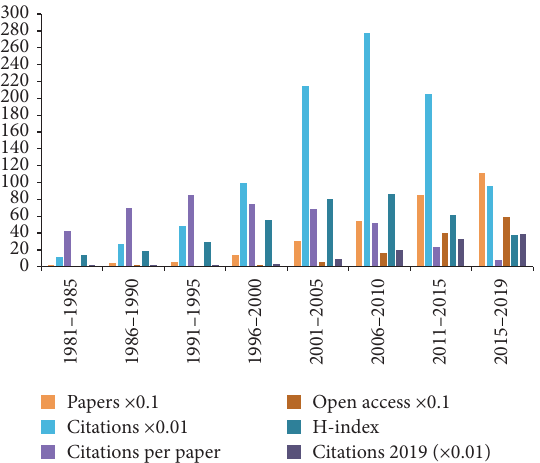
Figure 2: Number of papers, citations, citations per paper, open access paper, H-index, and citations in 2019 for each 5-year time Table 1: The top 20 journals of origin of papers in the pain and inflammation research.